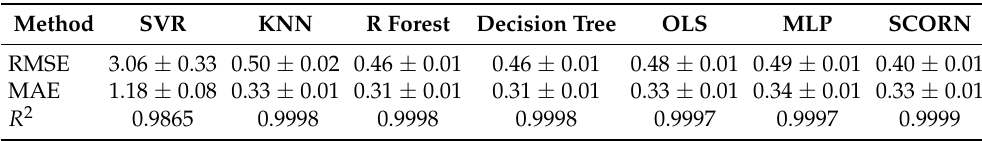
Table 3. Comparison of the SCORN models and the different methods (the variances of R 2 values are negligible because of their small values).